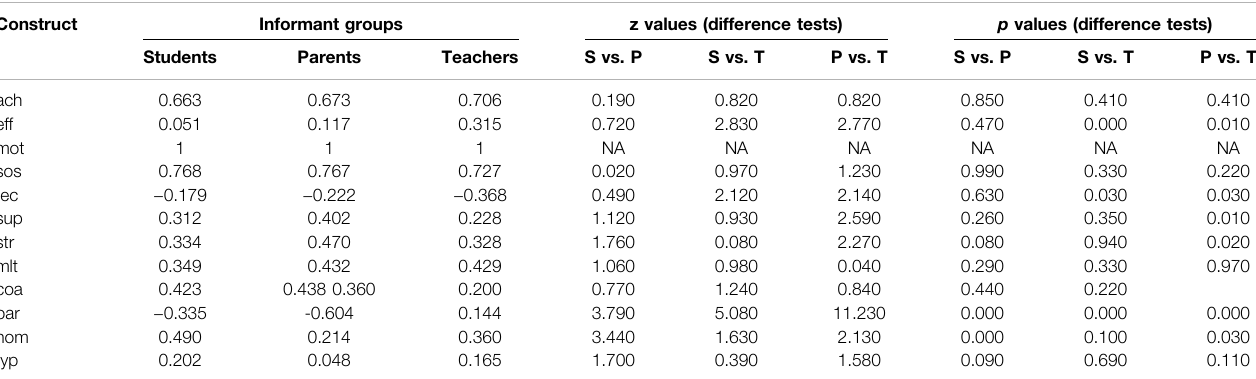
TABLE 6 | Latent correlations of the study variables with motivation